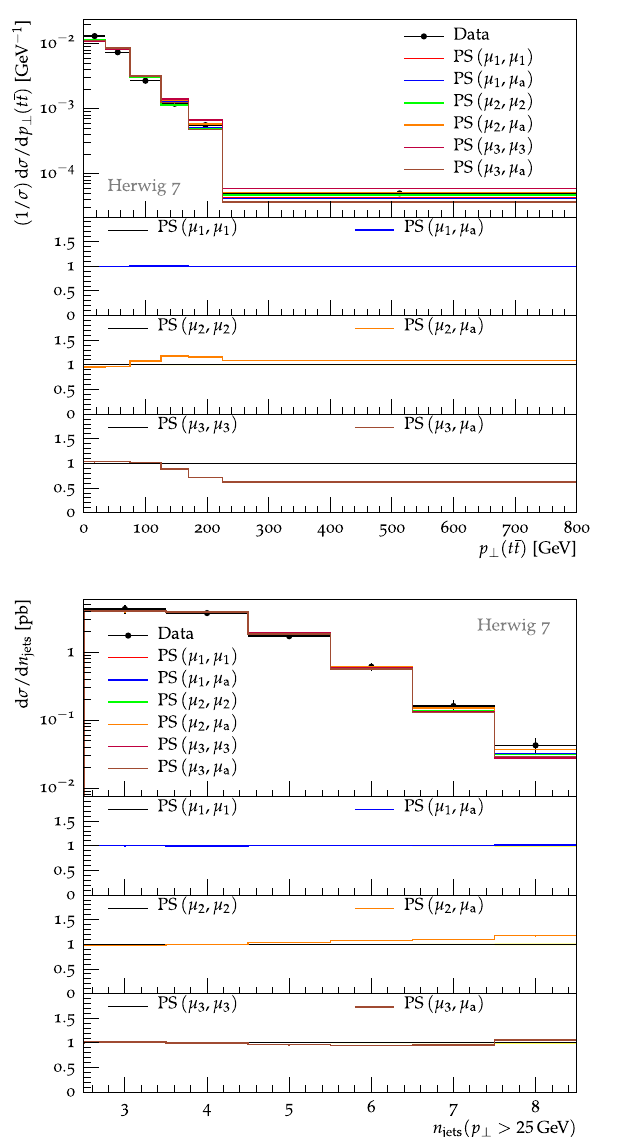
Fig. 14 Top: t ¯ t -pair transverse momentum measured by ATLAS in semileptonic 8TeV pp → t ¯ t events [64] and predicted using the angular-ordered(PS)anddipole(DS)partonshowers,respectively.Bot-